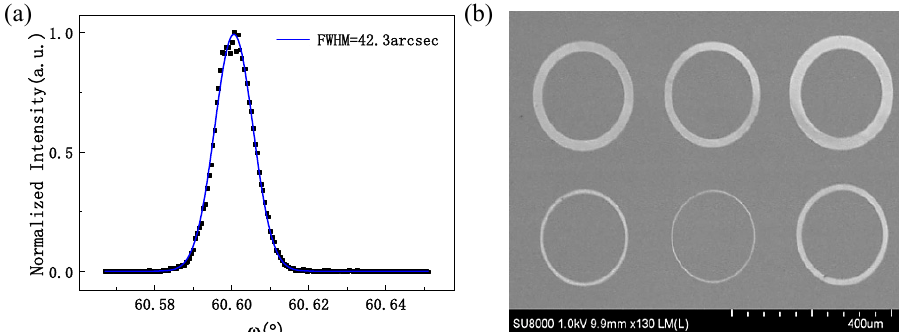
Figure 2. ( a ) XRD image of H-SCD, ( b ) SEM image of C-TLM structures fabricated on H-SCD.